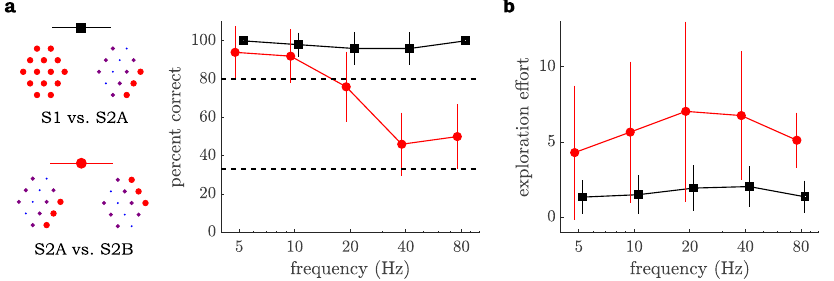
Figure 2. Results from Experiment 1. ( a ) Participants’ identification performance in the 3AFC task contrasting S1 vs S2A stimuli (black square) and S2A vs S2B (red circle). Chance identification and the probability associated with p = 0.05 statistical significance (derived under a binomial distribution) are shown as dashed lines. ( b ) Exploration effort during the identification task, represented by the average number of switches between stimuli beyond the minimum of two. Lines represent standard error. Exploration effort between two tasks is significantly different at all frequencies ( p < 0.001).